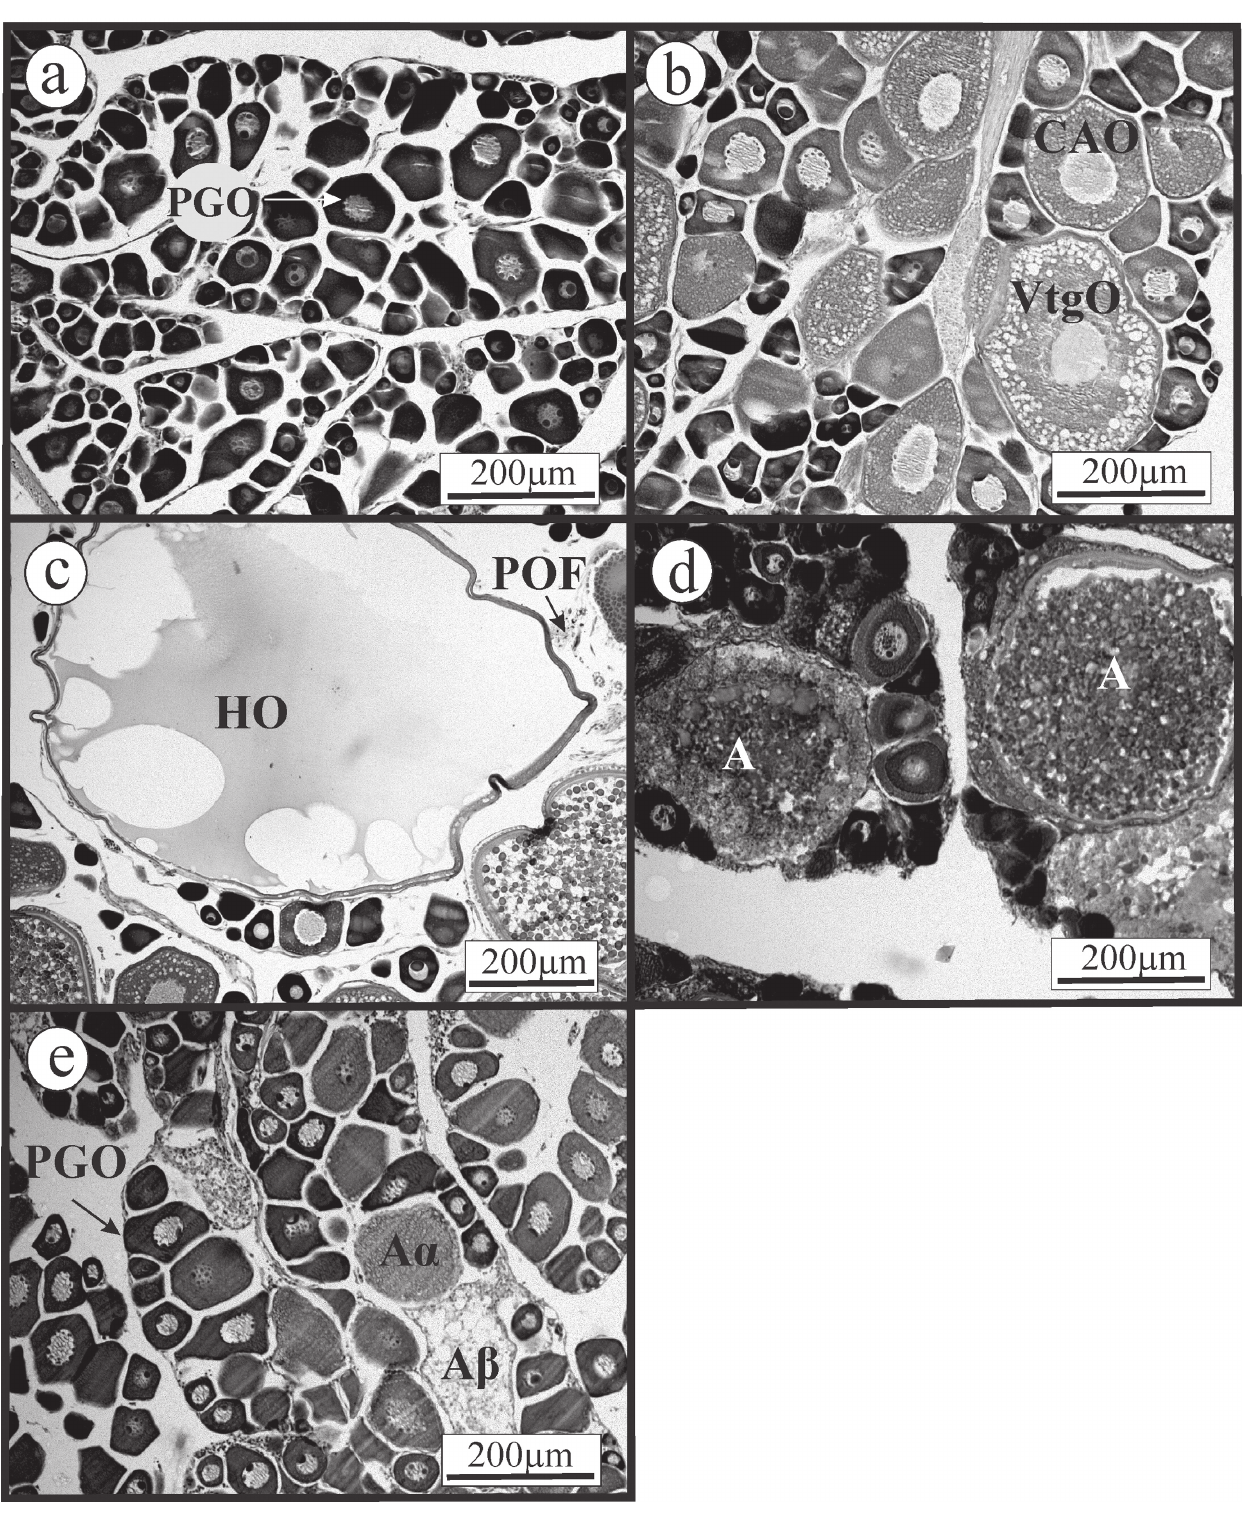
Fig. 1. Ovaries of Pinguipes brasilianus in different maturation stages. a) immature, b) developing, c) spawning capable, d) regressing, e) regenerating. A: atresia (α and β); CAO: Cortical alveoli oocyte; HO: hydrated oocyte; PGO: primary growth oocyte; POF: postovulatory follicle; VtgO: vitellogenic